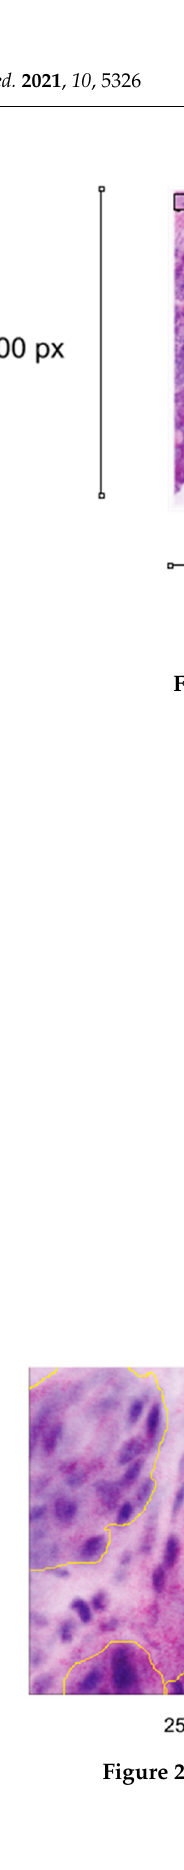
Figure 1. An example of an ex vivo FCM scan with a 256 × 256 px input image.